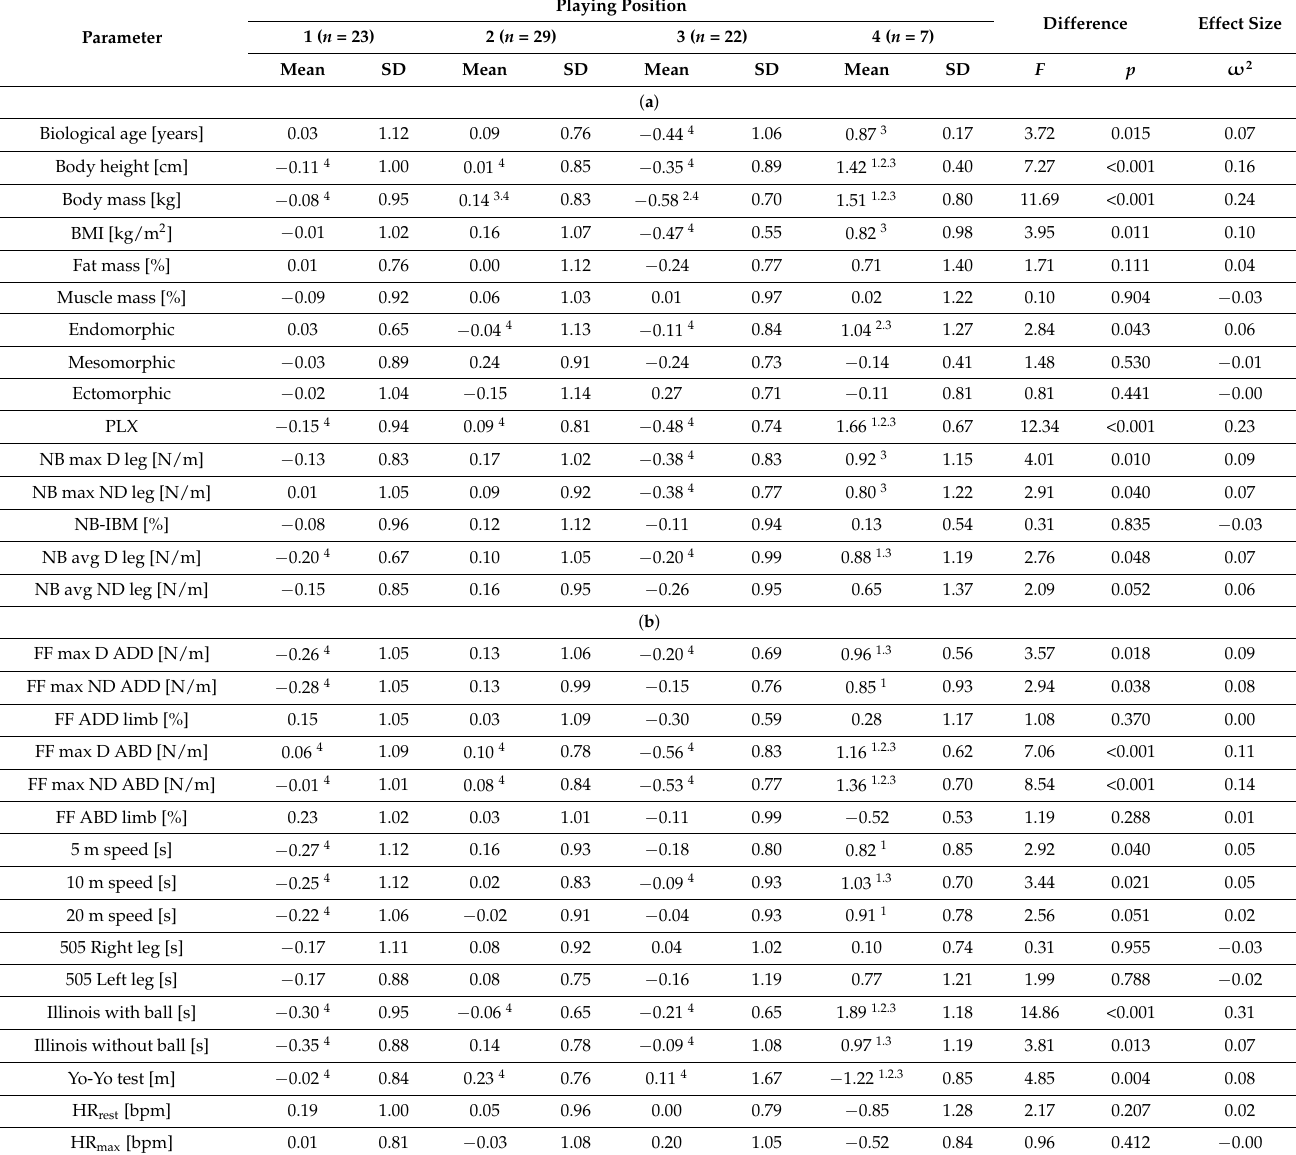
Table 2. ( a ) Descriptive and comparative analysis of the Z-scores of chronological and biological age and the anthropometric characteristics of soccer players assigned to different playing positions. ( b ) Descriptive and comparative analysis of the Z-scores of the physiological and performance parameters of soccer players assigned to different playing